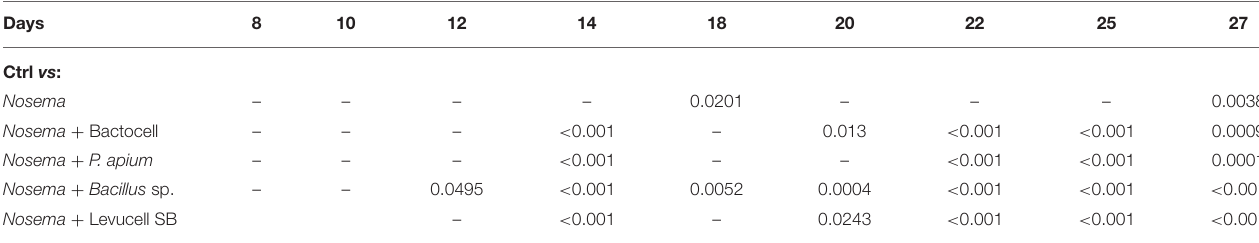
TABLE 4 | Cox Proportional Hazard model (Cox-model) comparisons between survival of the control group (ctrl) and Nosema group and experimental groups with curative administration of tested probiotics during the 27 days